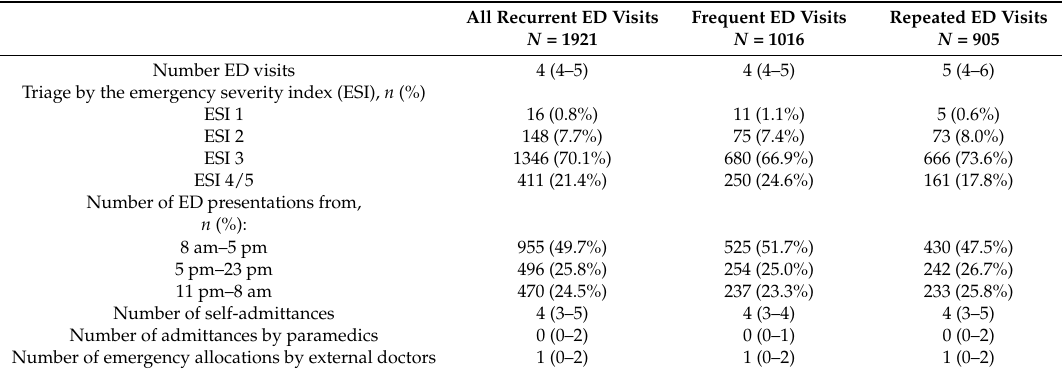
Table 3. Presentation of the recurrent ED patients in the Emergency